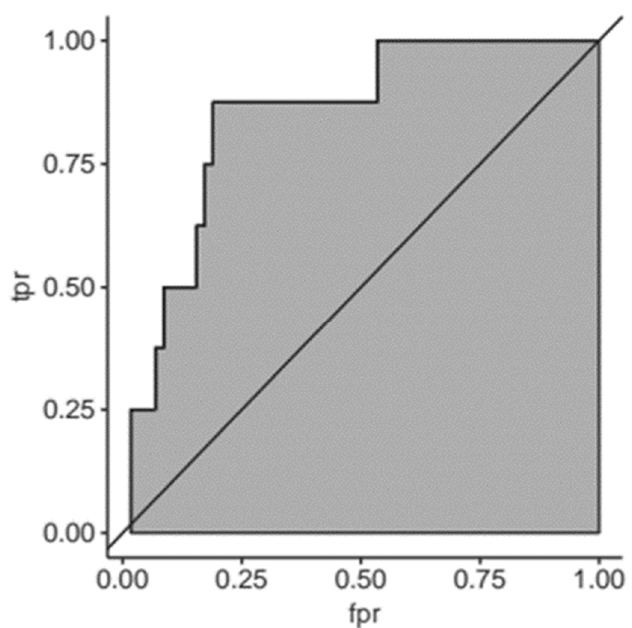
Figure 7. Receiver-Operator-Curve (ROC) analysis for SELENBP1 predicting adverse events. The receiver-operator-analysis for SELENBP1 concentrations and adverse events (death, cerebral ischemia, bradycardia) indicates a relatively meaningful predictive value (AUC; 0.8).